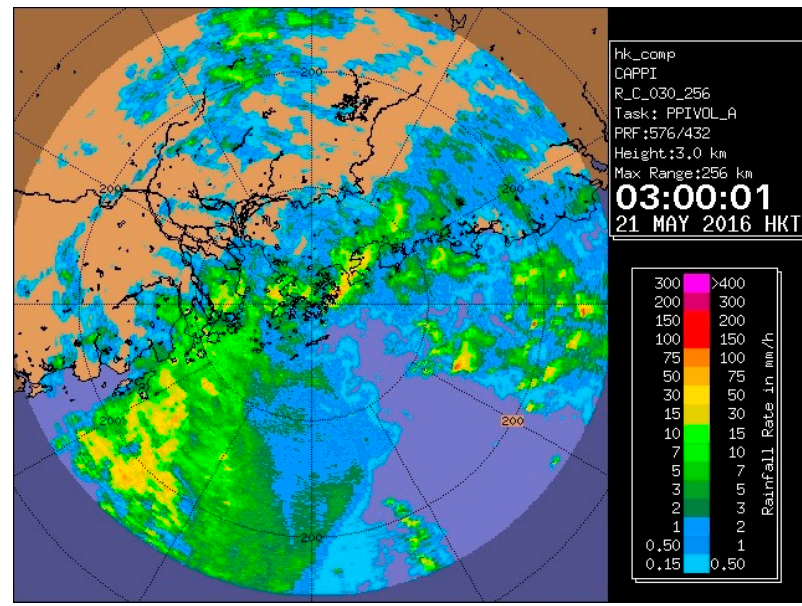
Figure 18. Radar imagery at 03:00 h on 21 May 2016.